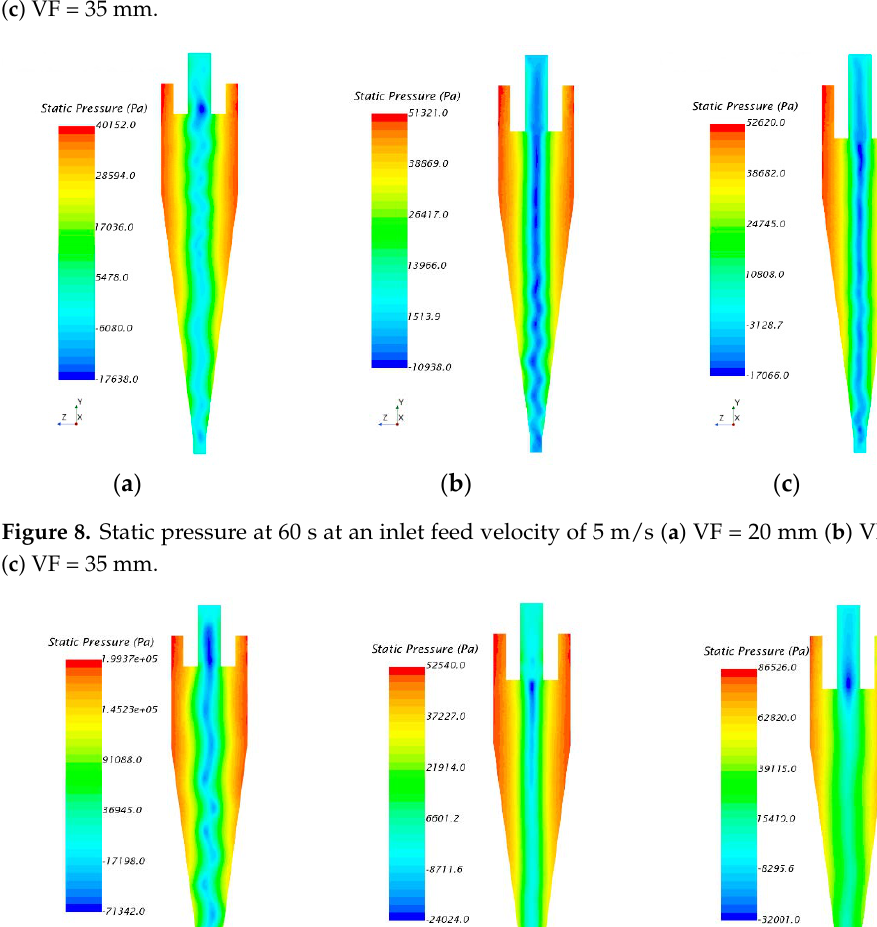
Figure 9. Static pressure at 60 s at an inlet feed velocity of 10 m/s ( a ) VF = 20 mm ( b ) VF= 30 mm ( c ) VF = 35 mm. It is noticed that the good feed velocity should be 5 m/s as it provides a consistent decrease in suction pressure in the center of the hydrocyclone across the three vortex finder lengths. It forms a desirable air core to effect separation but might be very close to the spigot’s diameter (underflow), which would cause a blockage if it grew further. It is not doing that at this instance, which is critically important for providing separation. The air core is not pronounced or consistent at higher feed speeds, as seen in Figures 8 and 9. An expectation is drawn in Figure 8b, where the velocity of 5 m/s makes better use of the friction length of the vortex finder (VF = 30 mm) and generates a suitable pressure drop to draw a suitable separation of the particles. 3.3. Effects of a Vortex Finder Length to a Split Water Ratio An increase in the split water ratio increases separation efficiency only for fine parti- cles; a drop in separation sharpness is seen in Figure 10. The overall partial separation